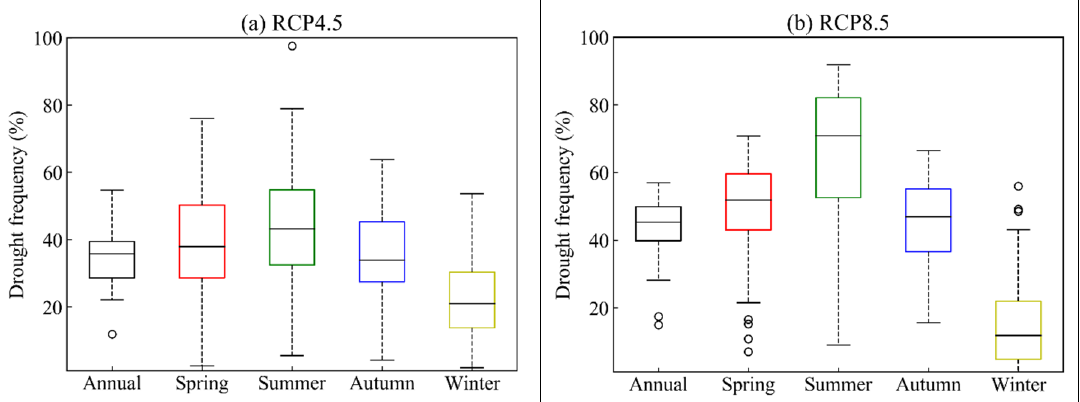
Figure 8. Seasonal frequencies of drought in the Mongolian Plateau under different representative concentration pathway (RCP) greenhouse gas scenarios during 2020–2100. ( a ) RCP4.5; ( b ) RCP8.5.